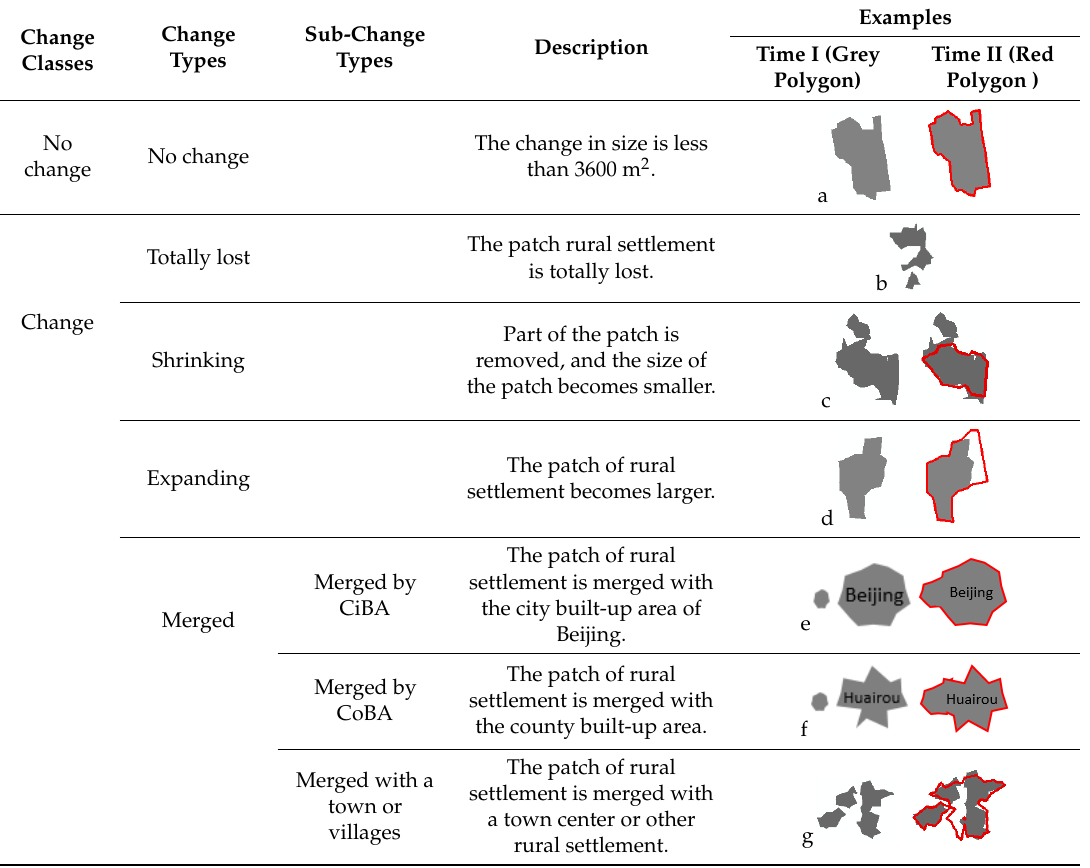
Table 1. The change types of rural residential settlement.